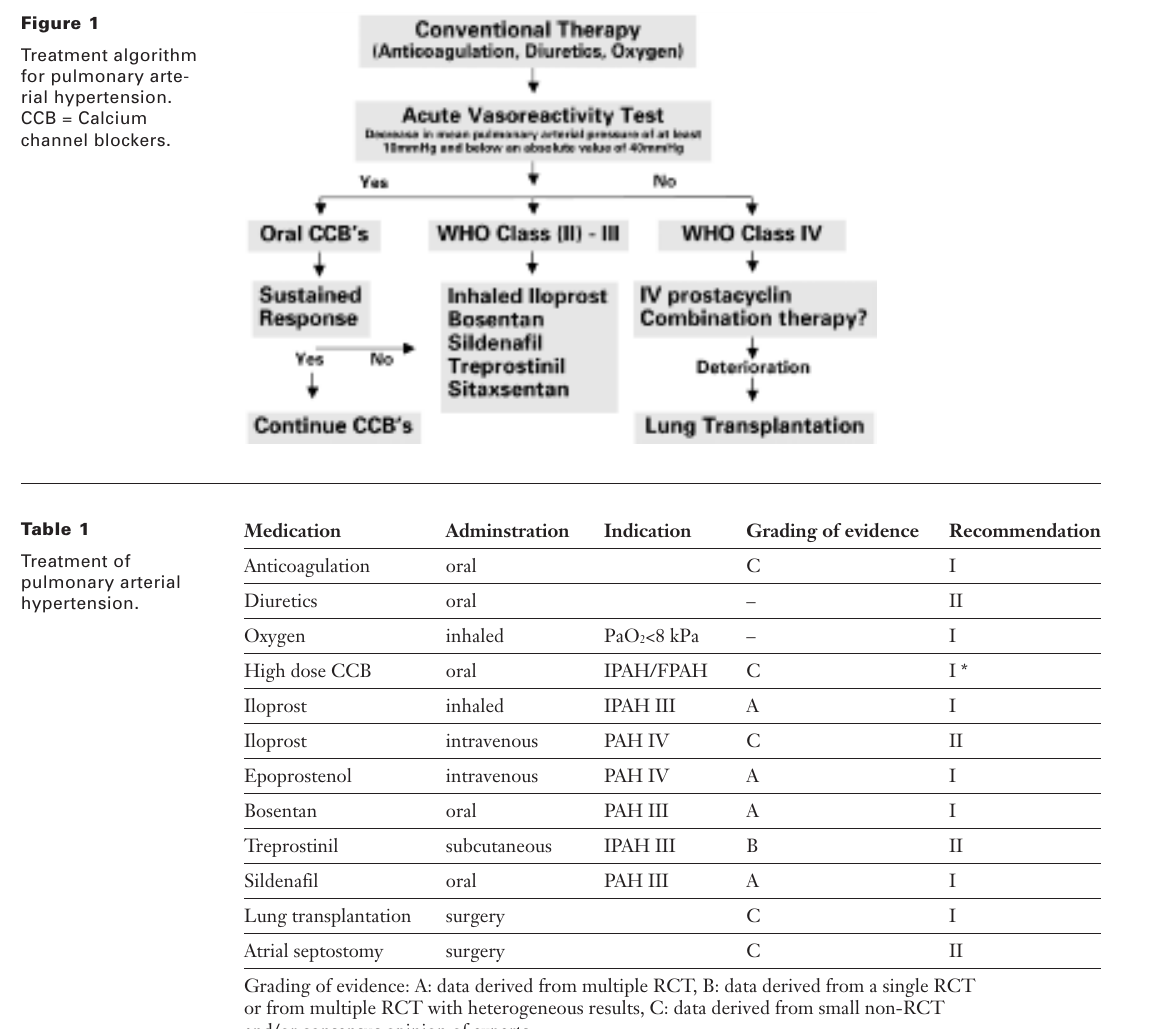
Table 2 Summary of thera- peutic approaches for pulmonary hyper-